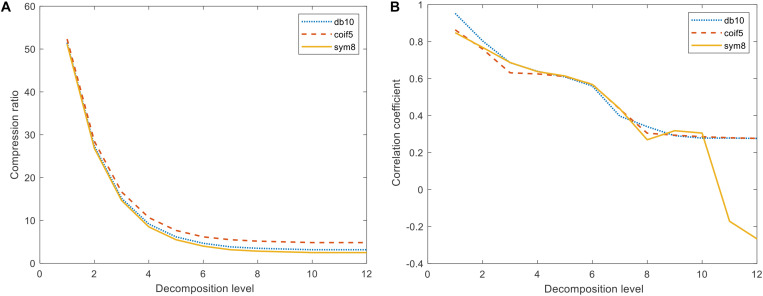
Compression ratio and correlation coefficient under different wavelet generating functions. (A) Variation of compression ratio with the number of decomposed layers. (B) Variation of correlation with the number of decomposition layers.